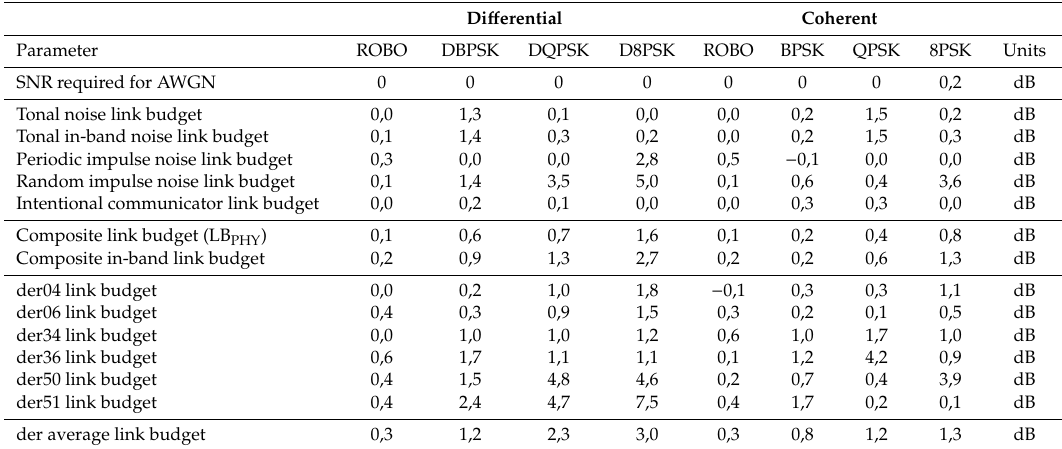
Table 12. Incremental results with a tone map power reallocation in G3-PLC compared to the standard tone map implementation (Table